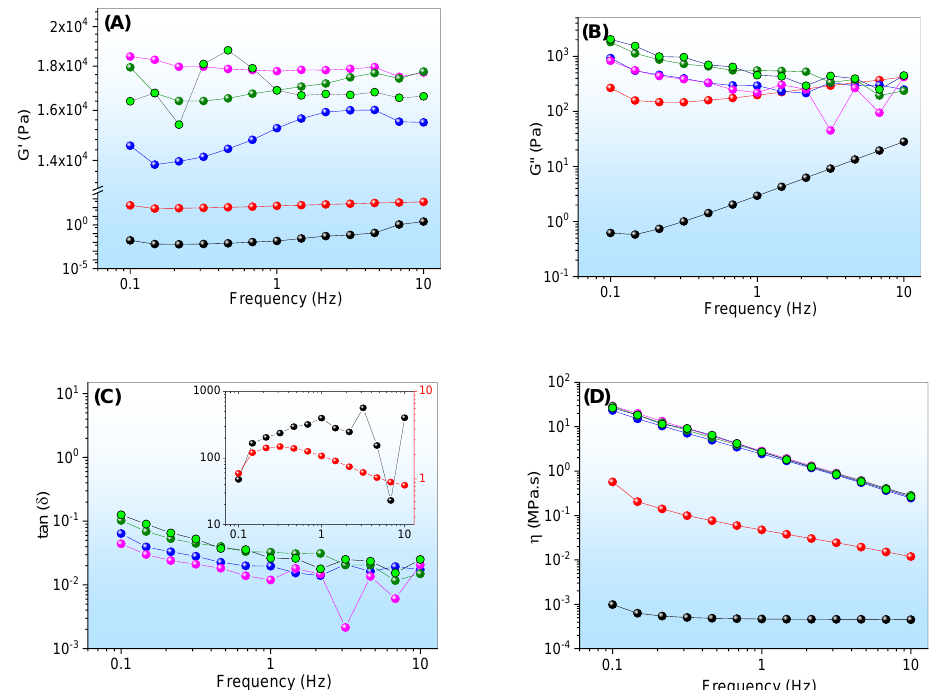
Figure 6. Viscoelastic properties of formulations in terms of oscillatory frequency: ( A ) elastic moduli (G ′ ); ( B ) viscous moduli (G ″ ); ( C ) loss tangent (Tan δ); ( D ) dynamic viscosity (η′ ). The symbols refer to EOCh-0.5 at 5.0 °C, EOCh-1.0 at 5.0 °C, EOCh-0.5 at 25.0 °C, EOCh-1.0 at 25.0 °C, EOCh-0.5 at 37.0 °C, and EOCh-1.0 at 37.0°C. The insert ( C ) corresponds to the viscoelastic data at 5.0 °C. The formulations showed an elastic modulus (G (cid:48) ) higher than the viscous modulus (G (cid:48)(cid:48) ) throughout the frequency sweep at 25.0 ◦ and 37.0 ◦ C, which provided tangent